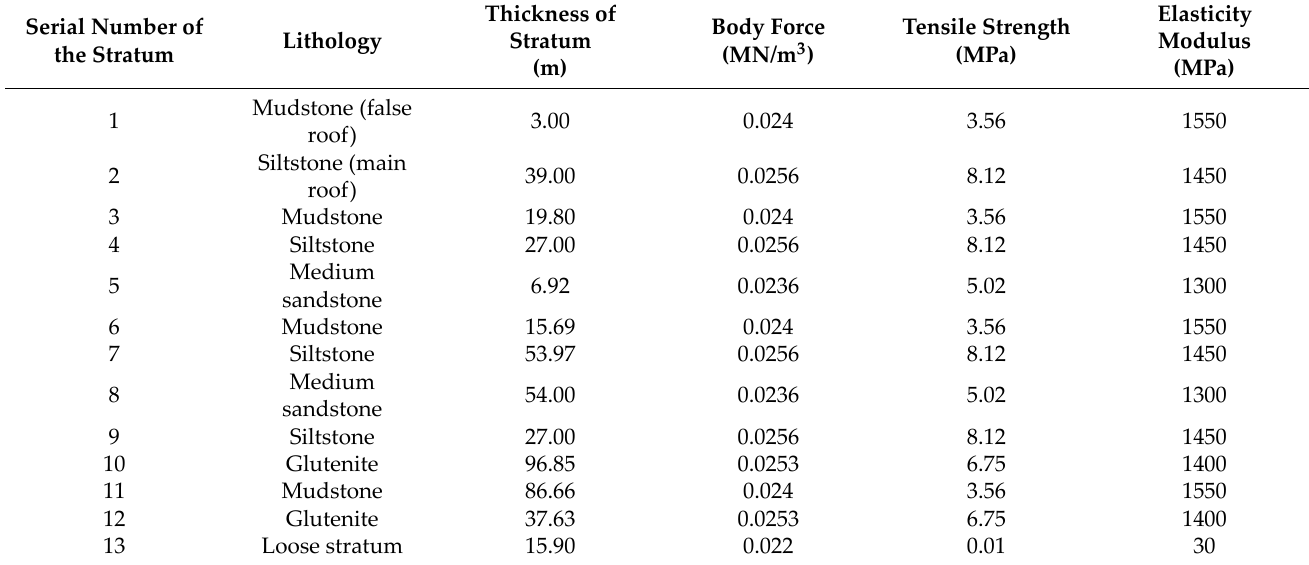
Table 4. Physical and mechanical parameters of the overlying strata.